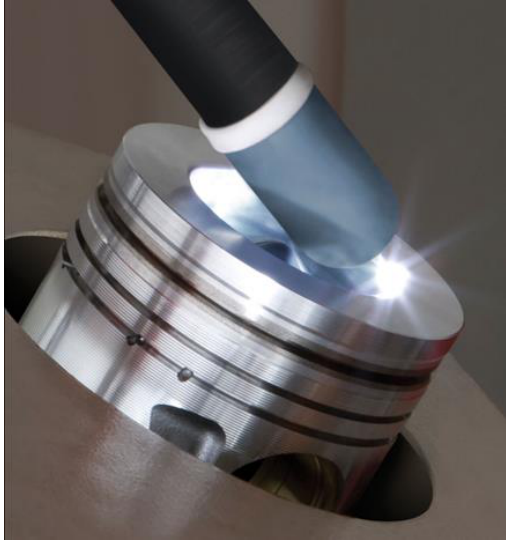
Fig. 6. Simulation of the fistula at the rim of the combustion chamber